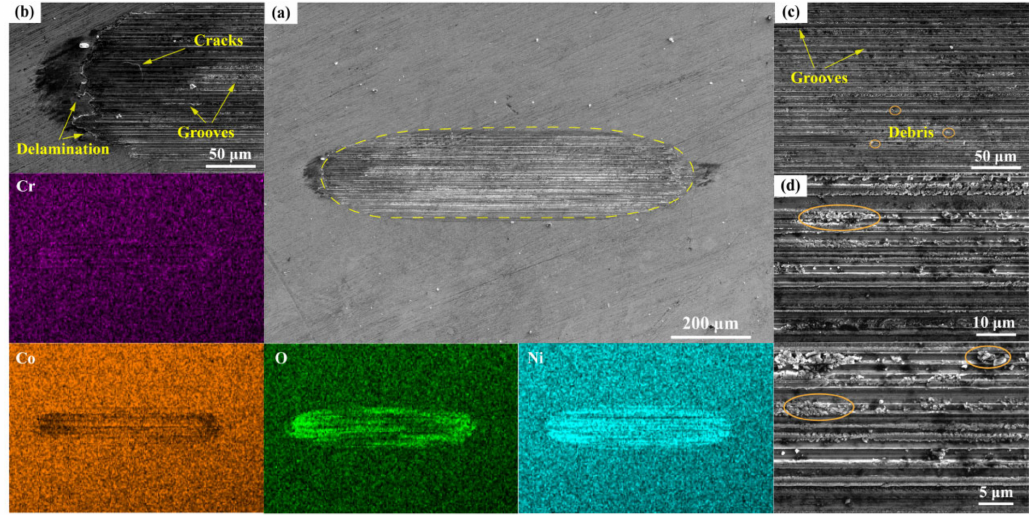
Figure 10. SEM and EDS micrographs of overall morphology ( a ) and some details ( b - d ) of the wear track for CoCrNi tested at an applied potential of − 0.2 V.